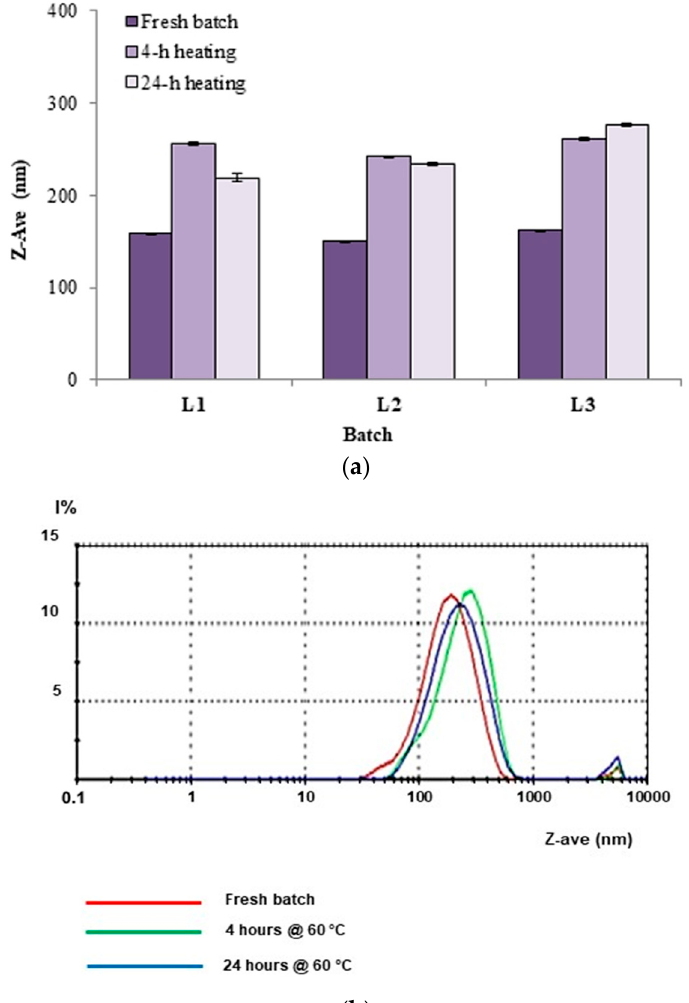
Figure 9. ( a ) Z-Ave values of fresh nanoparticle suspensions or after heating at 60 °C for 4 or 24 h; ( b ) size distribution of nanoparticles kept in at 60° C for 4 or 24 h.